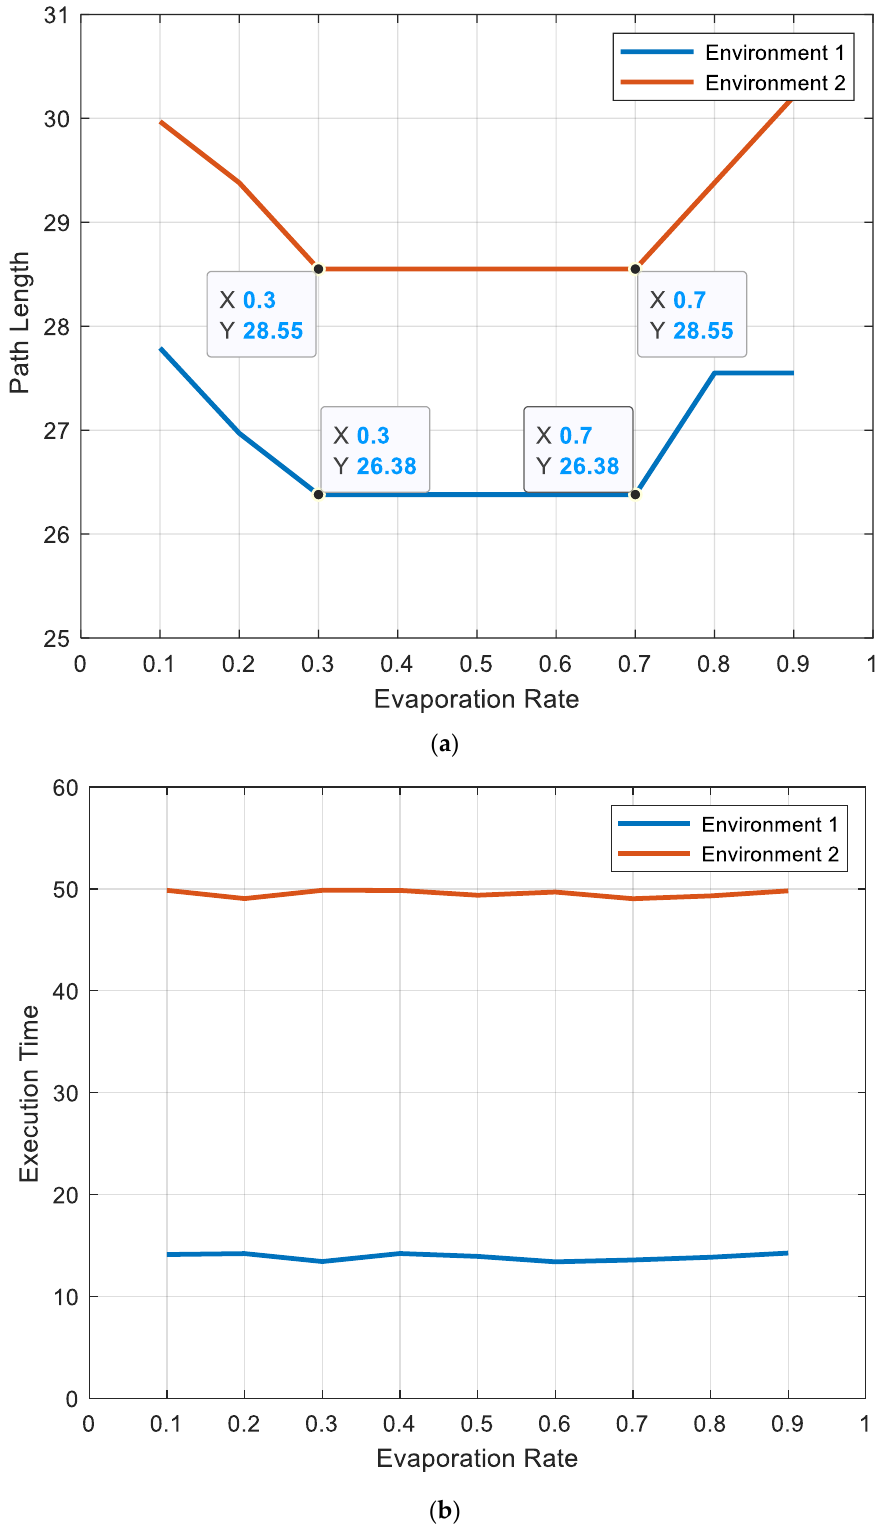
Figure 11. Effect of evaporation factor ( ρ ) on ( a ) path length and ( b ) execution time for environment 1 and environment 2.